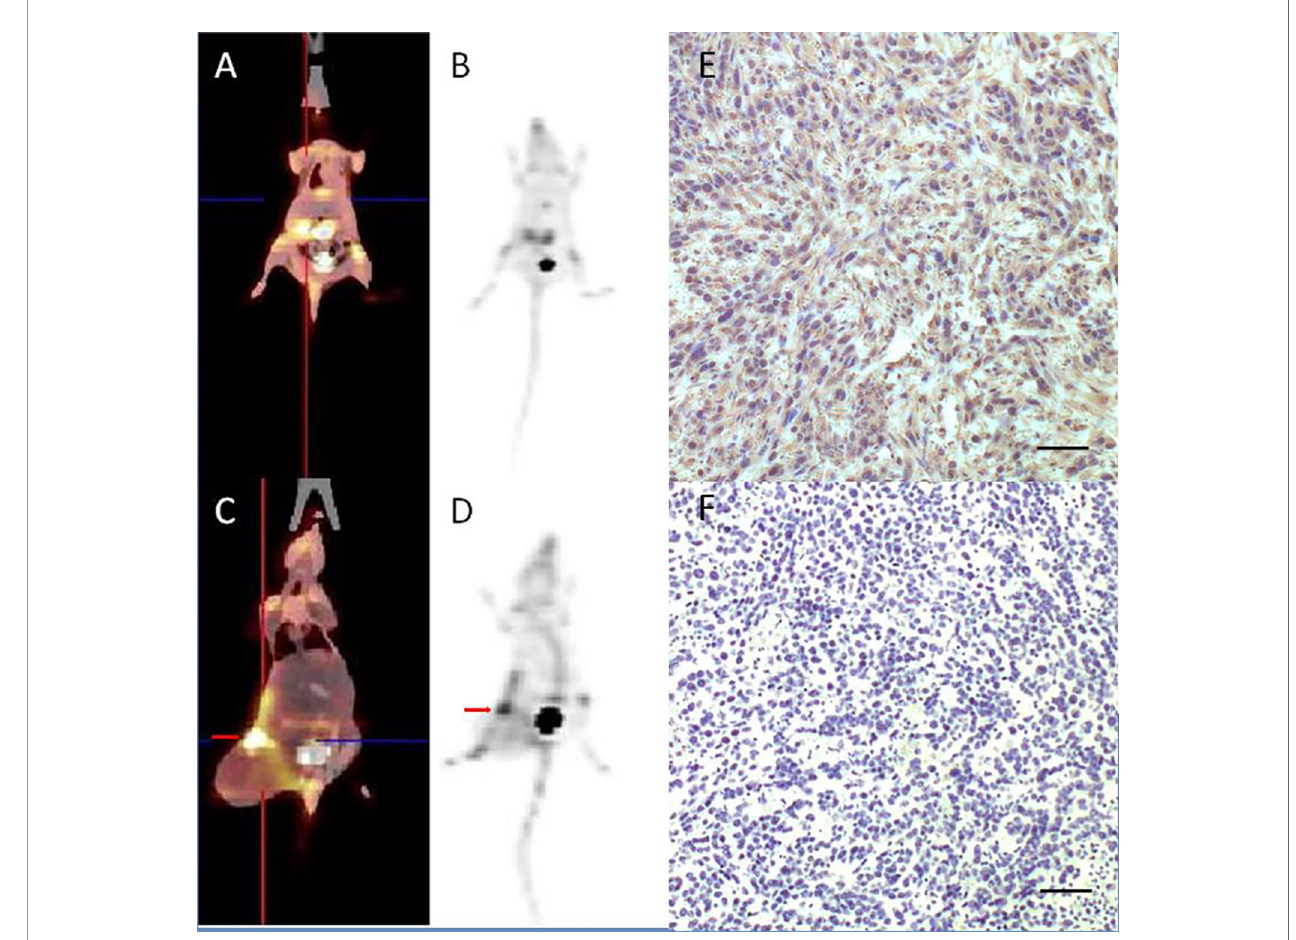
FIGURE 4 | [ 18 F]AlF-NOTA-FAPI-04 PET/CT imaging of normal BALB/c mice (A, B) and 4T1 breast cancer models ( C, D , red arrow indicates tumor). FAP IHC staining of 4T1 tumor tissue (E) showed 4T1 tumor tissue with high FAP expressing and control group without anti-FAP antibody (F) showed there is no false positive in FAP IHC staining results. Scale bar, 100 m